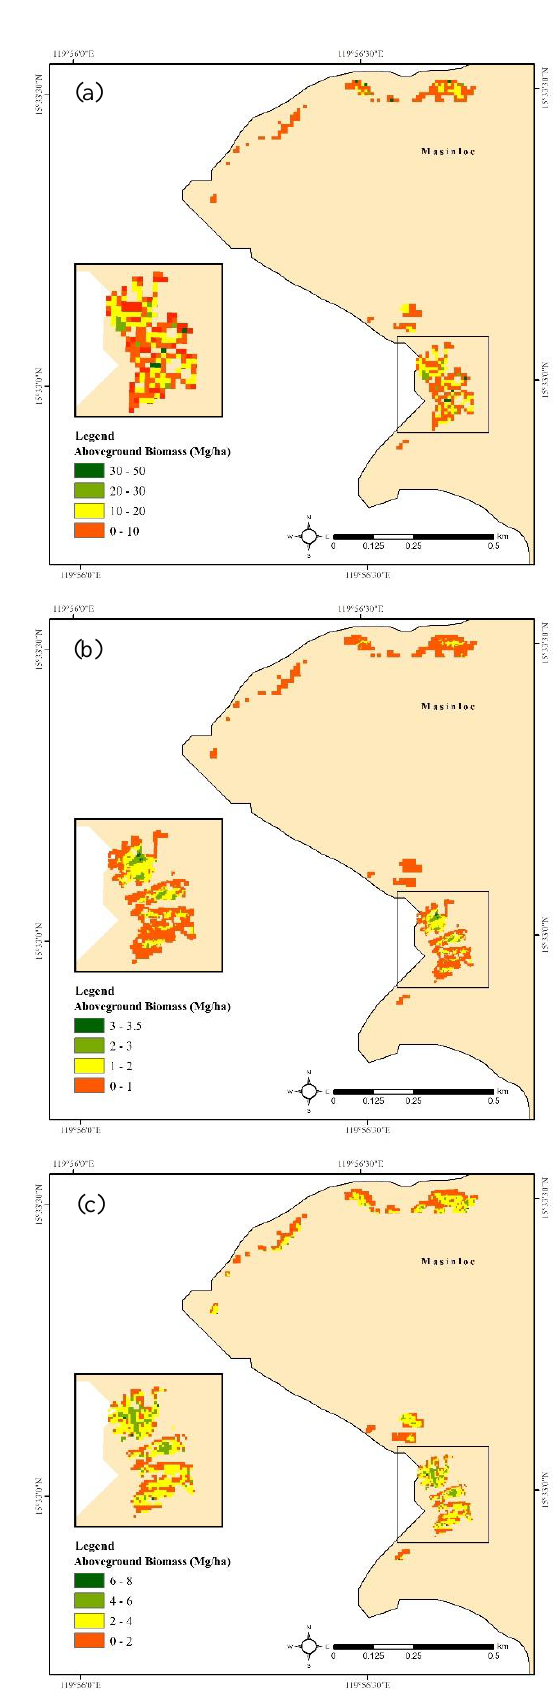
Figure 4. Predicted Aboveground Biomass Map using data from a) Sentinel-2, b) RapidEye and c) PlanetScope